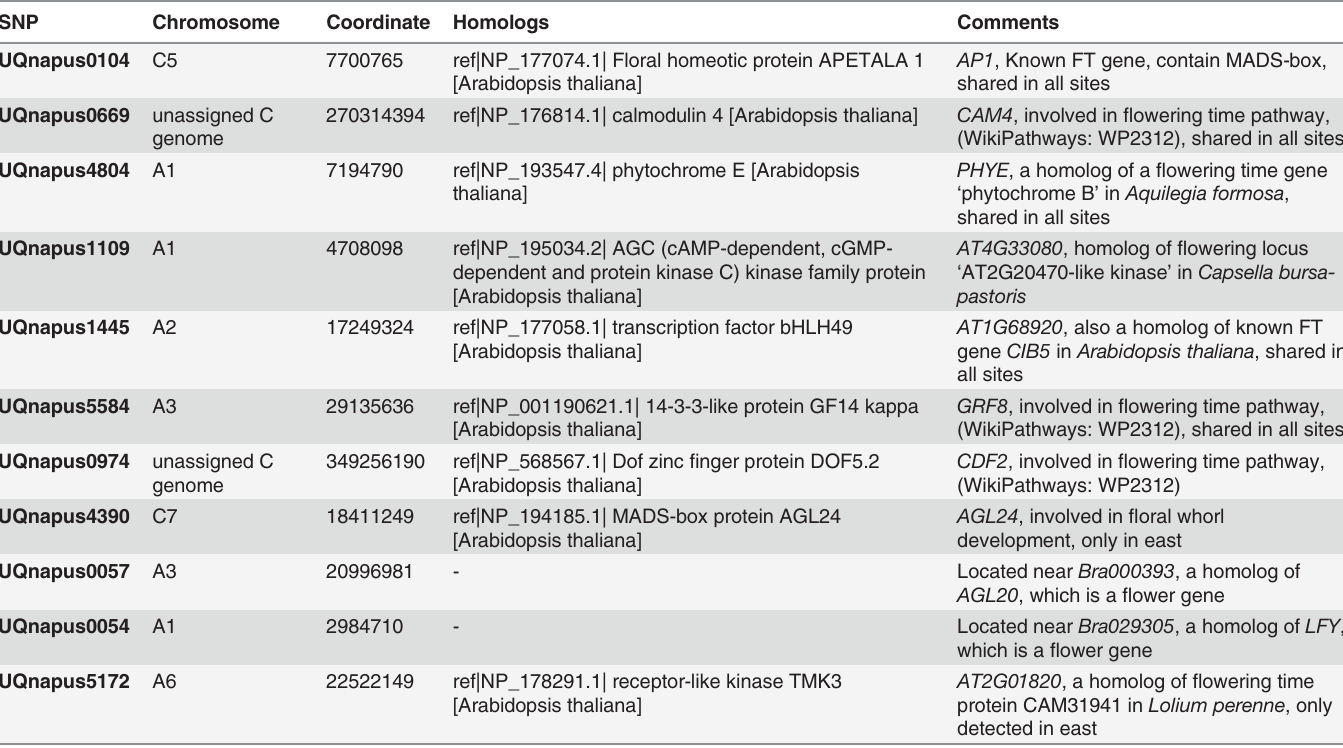
Table 2. Associated SNPs tagging known FT